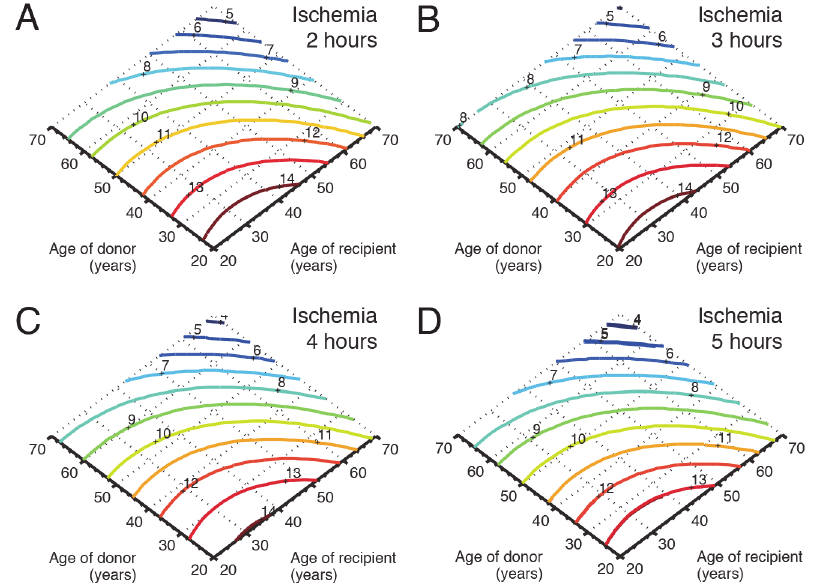
Fig 3. Influence of age and duration of ischemia on survival. Panel (A) illustrates, in matched cohorts, the influence of donor age and recipient age on survival when the duration of ischemia is fixed to 2 hours, and panels B, C, and D illustrate the influence on survival at 3, 4, and 5 hours of ischemia, respectively. The colored solid lines show the predicted survival in years (dark blue: worst; dark red: best).